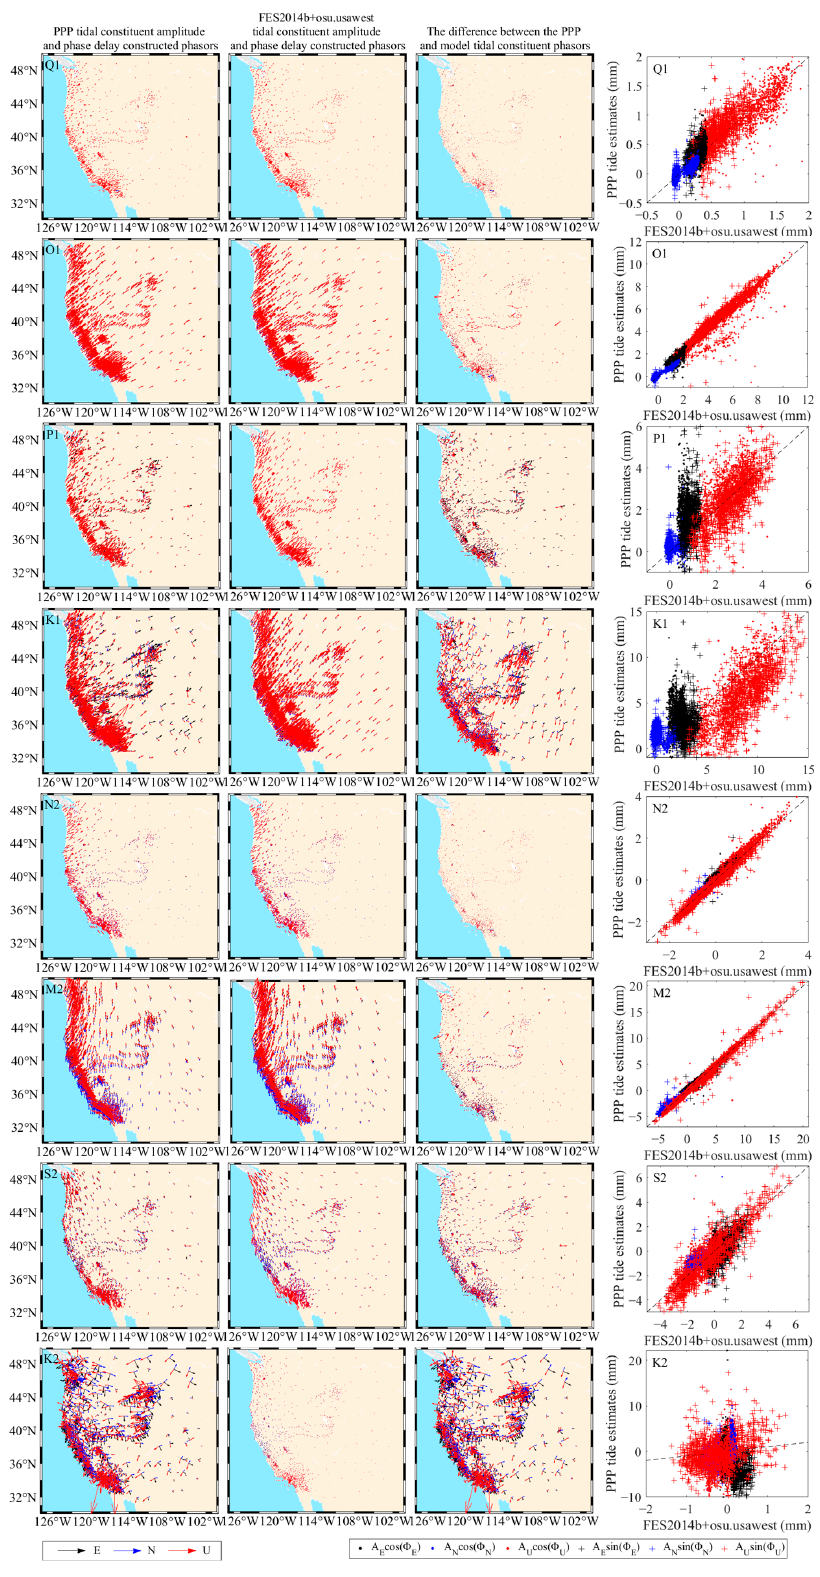
Figure 3. Comparative analysis of the phasor of tidal constituents estimated by the kinematic PPP technique and FES2014b+osu.usawest models.